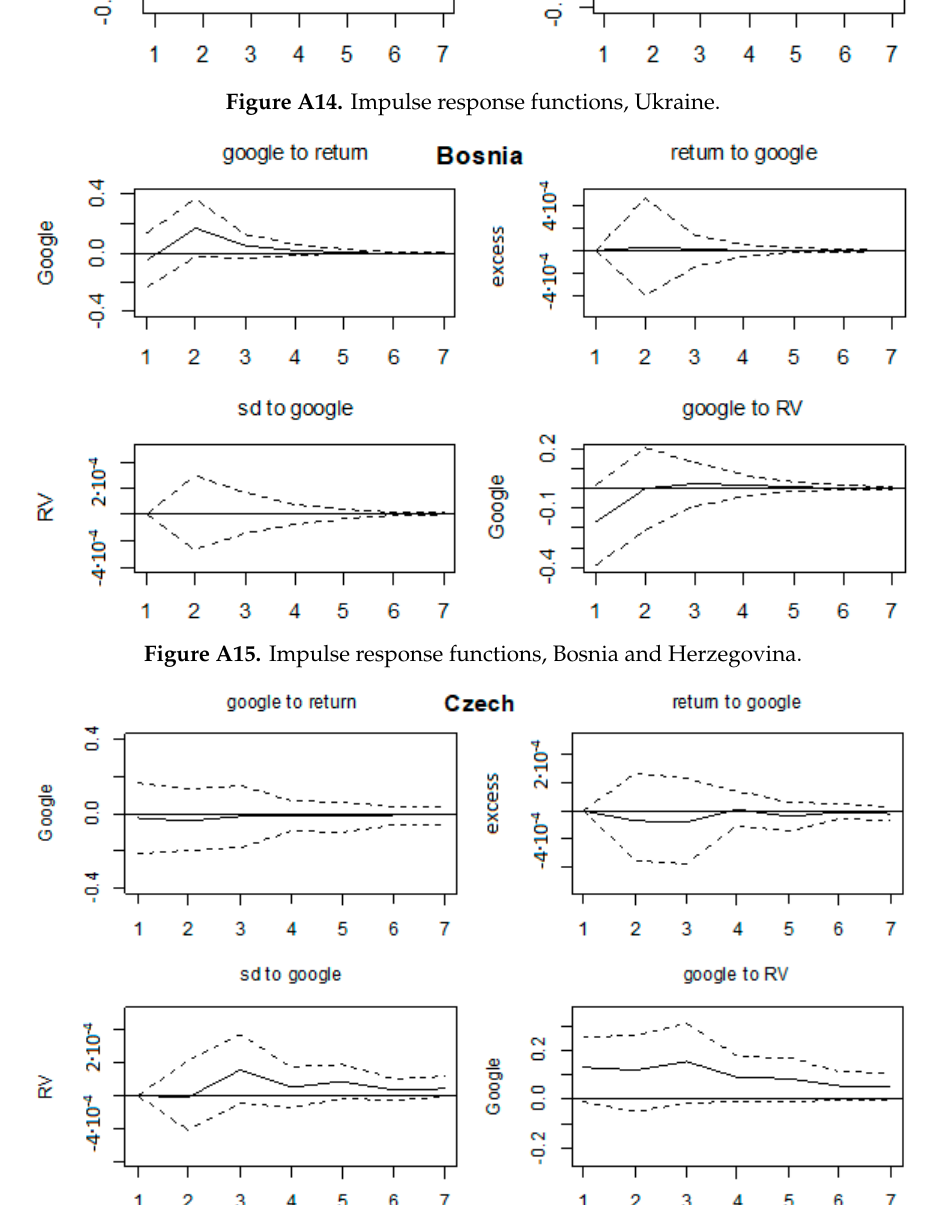
Figure A17. Impulse response functions, Slovakia. Figure A18. Impulse response functions, Slovenia.